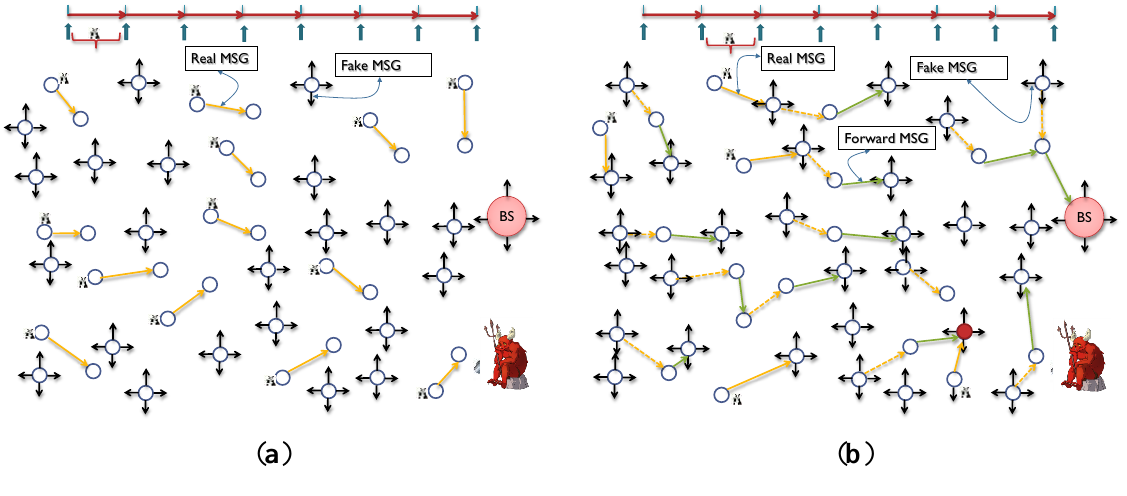
Figure 12. Anonymity with fake messages. ( a ) Sensors sense events and send real messages while the rest send fake messages. With Fake MSG’s: 𝑃 1 1 MSG’s: 𝑃 = = = 9% ; ( b ) Sensors send or forward real messages will not send 𝑟 𝑛 11